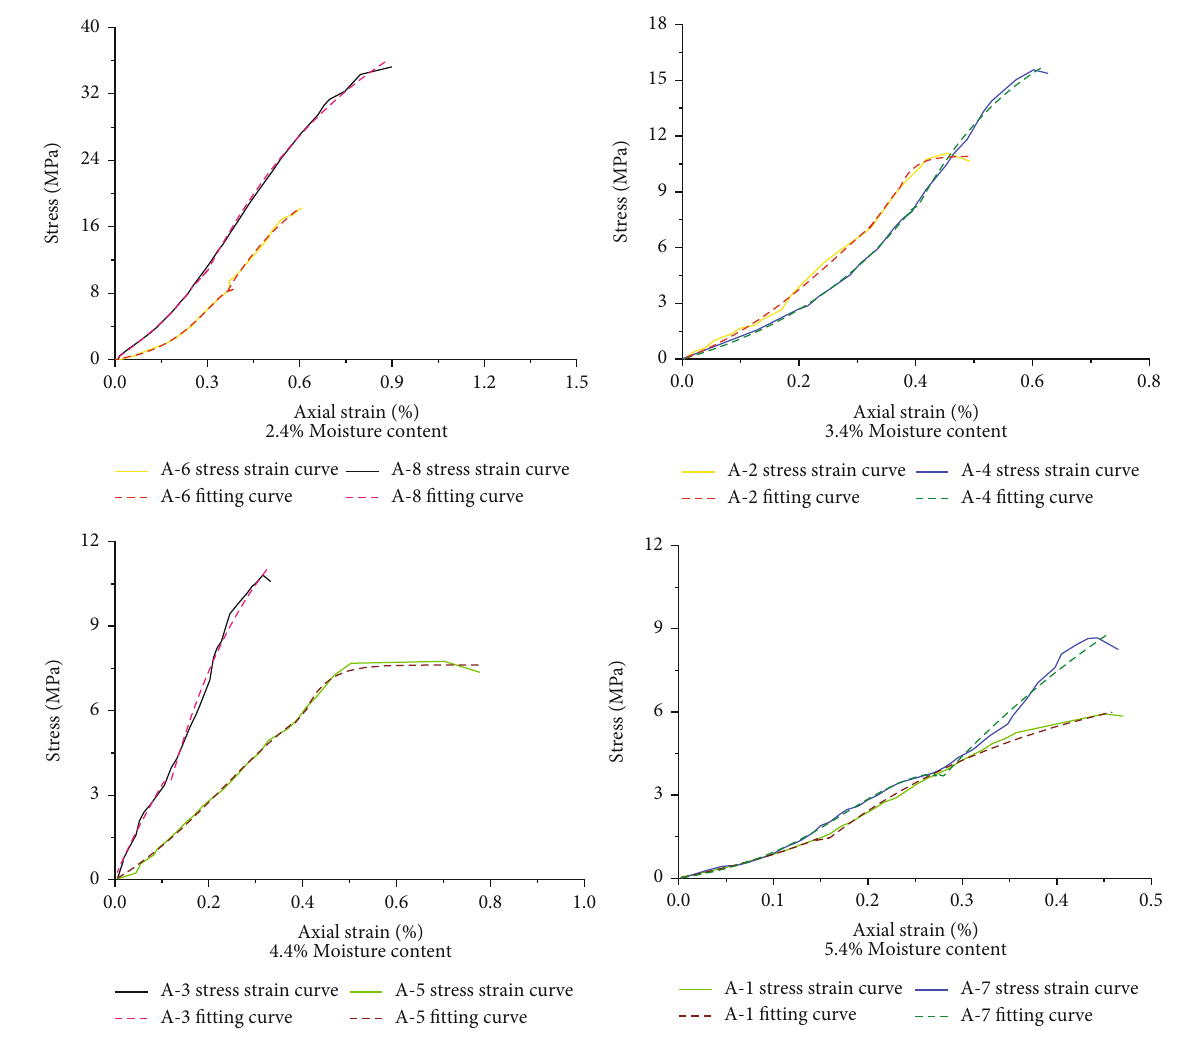
Figure 16: Fitting diagram of di ff erent water